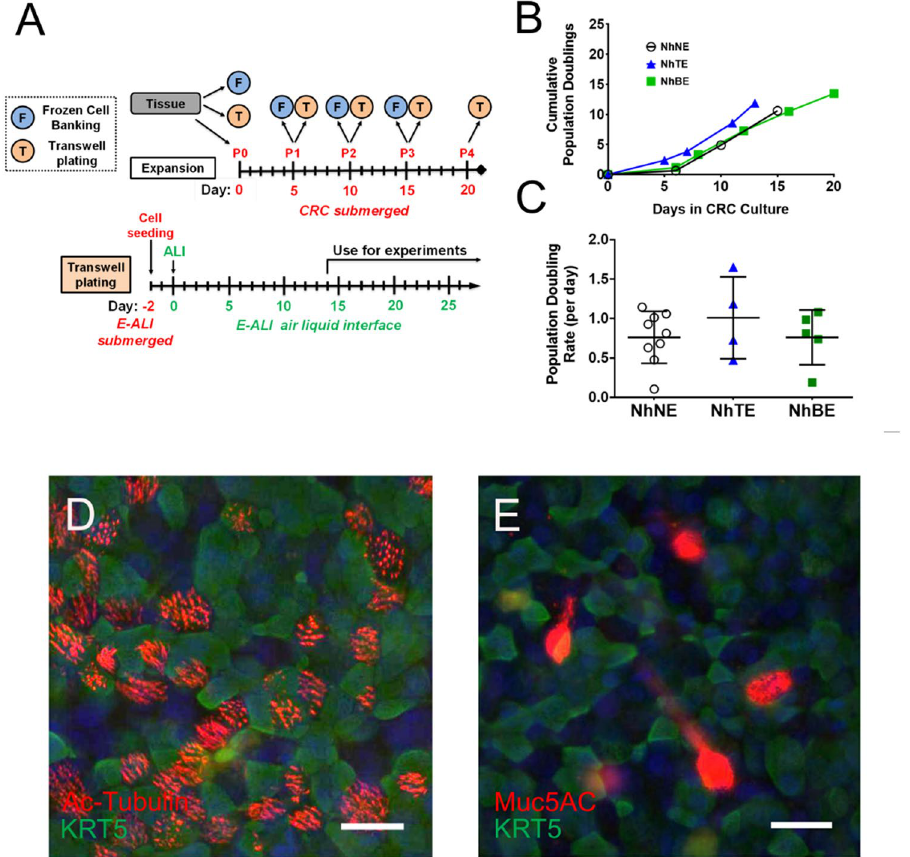
Figure 2. Airway epithelial cells from different tissue sources propagate with similar doubling times. ( A ) Timeline for processing of cells isolated from lung tissue samples showing frozen cell banking (F), plating for differentiation on Transwell permeable supports (T) or plating for expansion under CRC conditions. Cells from P0 through P3 are banked. Cells beyond P4 are not typically used to generate differentiated cultures for experimental analysis. Detail related to culture on Transwells (T) is shown below, indicating the shift from submerged to air–liquid interface (ALI). Cells are cultured at least 14 days at ALI prior to use in experiments. ( B ) Representative NhNE, NhTE, and NhBE displayed a lag phase of growth between Day 0 and Day 5 in CRC conditions before replicating at a linear rate. ( C ) Regardless of anatomical origin or the initial lag phase, airway epithelial cells showed comparable doubling rates under CRC conditions. n = 2 – 3 wells from n = 2 (NhTE, NhBE) or 4 (NhNE) biological replicates plotted as mean ± SD. ( D , E ) Immunofluorescence analysis of differentiated tracheal epithelial cells (NhTE) at Day 14 in E-ALI. Ciliated cells were identified by immunostaining for acetylated tubulin (Ac-Tubulin, red) and basal cells by cytokeratin 5 (KRT5, green). Nuclei were labeled with DAPI (blue). ( D ). Mucus producing cells were identified by Muc5AC expression (red) ( E ). Bar, 20